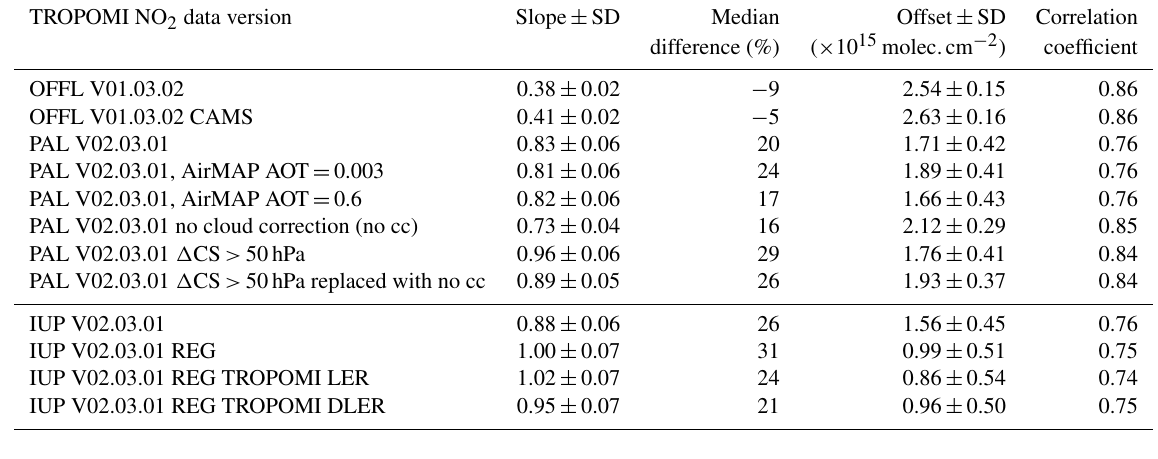
Table A1. Statistics of the comparisons between the different TROPOMI tropospheric NO 2 VCD data versions and AirMAP measure- ments: slope and offset ± standard deviation (SD) of the orthogonal distance regression, median relative difference, and Pearson correlation coefficient.